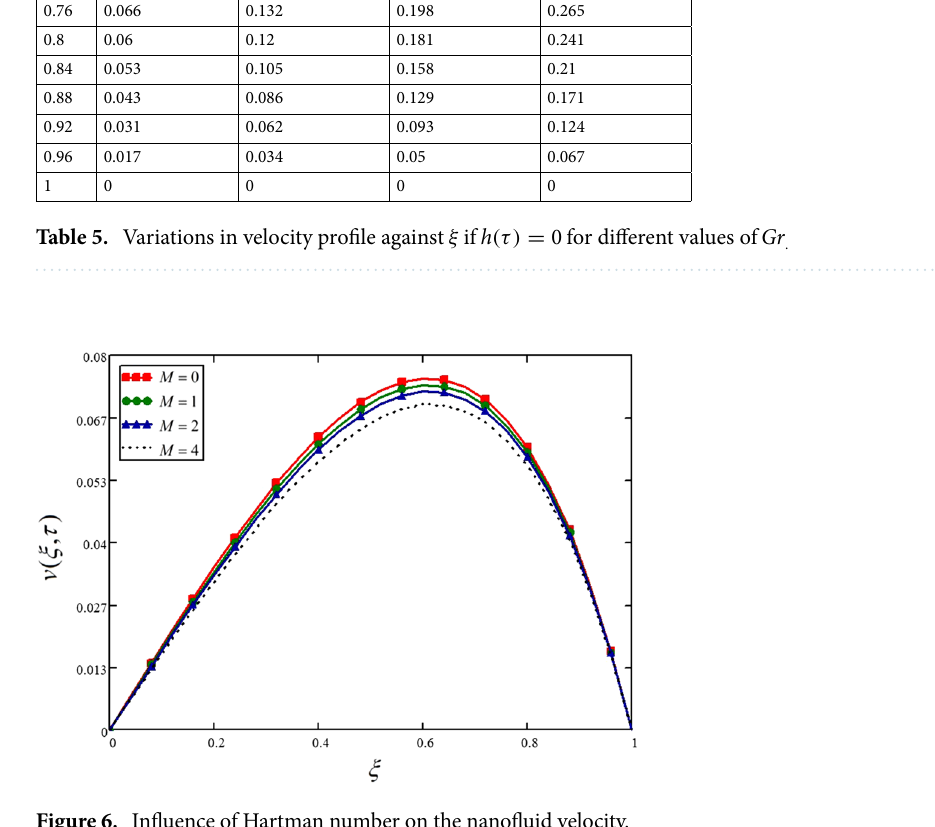
Figure 6. Influence of Hartman number on the nanofluid